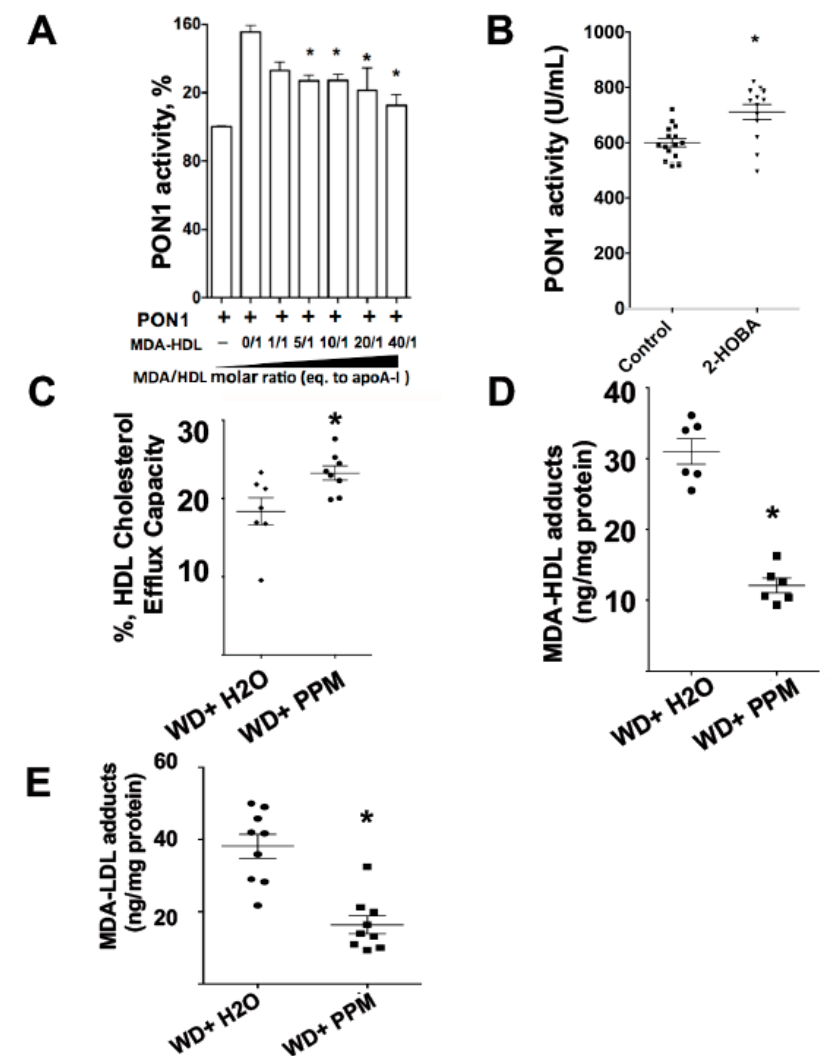
Figure 4. E ff ects of HDL MDA modification and reactive dicarbonyl scavenging on PON1 activity. The PON1 activity assay was performed using the EnzCheck PON1 activity kit (Thermo Fisher Scientific), which measures the organophosphatase activity of PON1. PON1 standards and diluted human serum samples were prepared in TSC bu ff er. The samples and standards were then incubated for 30 min with TSC bu ff er containing 100 µ M substrate. Fluorescence intensity was then measured using Biotek’s Synergy MX Microplate reader after 30 min of incubation at 37 ◦ C. The e ff ect of MDA modification of HDL on PON1 activity was measured ( A ). The PON1 activity was measured in plasma of Ldlr − / − mice ( n = 15 in control, n = 13 in treatment group) consuming a western diet and treated with water alone or with the reactive scavenger, 2-HOBA ( B ). The cholesterol e ffl ux capacity of HDL from Ldlr − / − mice treated with water alone or with the reactive dicarbonyl scavenger, PPM ( C ). MDA-HDL ( D ) and MDA-LDL ( E ) levels were measured in Ldlr − / − mice treated with the reactive dicarbonyl scavenger PPM using ELISA. Graphs represent data (mean ± SEM) of the experiments; * p < 0.05 is indicated by T-test or by comparing with HDL-PON1 group ( A ) one way